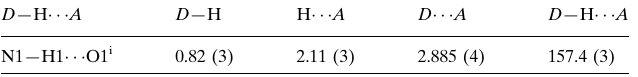
Hydrogen-bond geometry (A˚ , (cid:1)